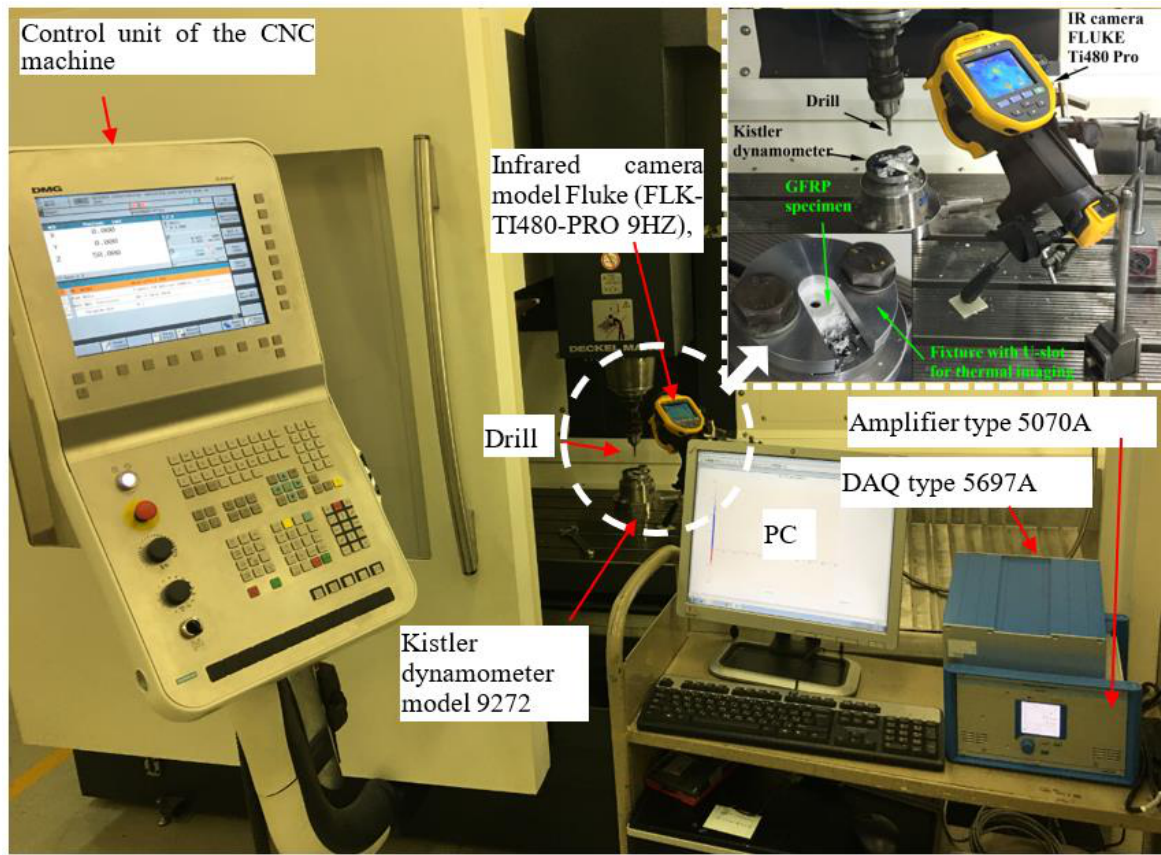
Figure 2. Drilling setup using CNC machine model Deckel Maho DMG DMC 1035